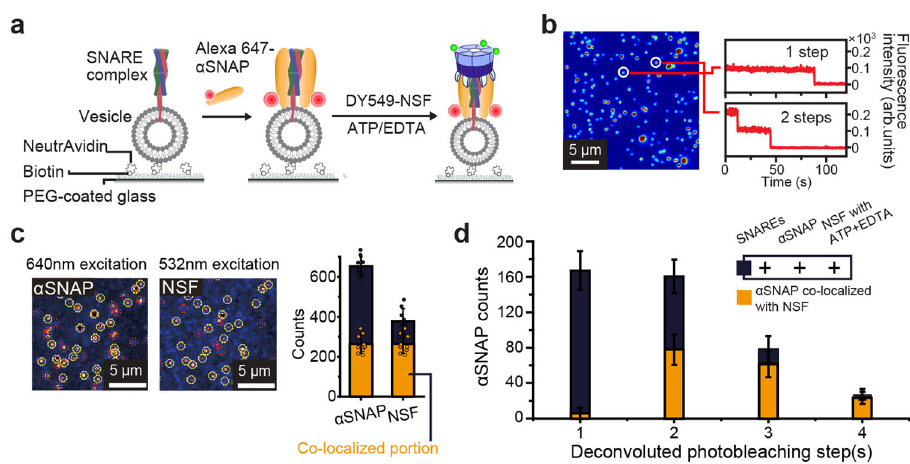
Fig. 2 α SNAP dimers are the minimal units that connect NSF and SNARE complexes. a Schematic for stoichiometry determination of α SNAPs bound to surface-immobilized SNARE-incorporating vesicles. b Representative fl uorescence intensity traces for the single spots in the image with the corresponding number of photobleaching step(s). c Representative fl uorescence images of Alexa647-labeled α SNAP and DY549-labeled NSF from a total internal re fl ection fl uorescence (TIRF) microscope and the corresponding counts of proteins and co-localized portions. d Deconvoluted histogram of the photobleaching step(s) for labeled α SNAP in single spots examining the number of α SNAP for NSF binding. The histogram of photobleaching step(s) in d was deconvoluted accounting for the 90% labeling ef fi ciency. Error bars in ( c , d ) represent mean ± s.d. for n = 9 images from two independent experiments ( c ) and n = 12 images from three independent experiments ( d ). The reproducibility of the images ( b , c ) was con fi rmed in three independent experiments. Source data are provided as a Source Data fi